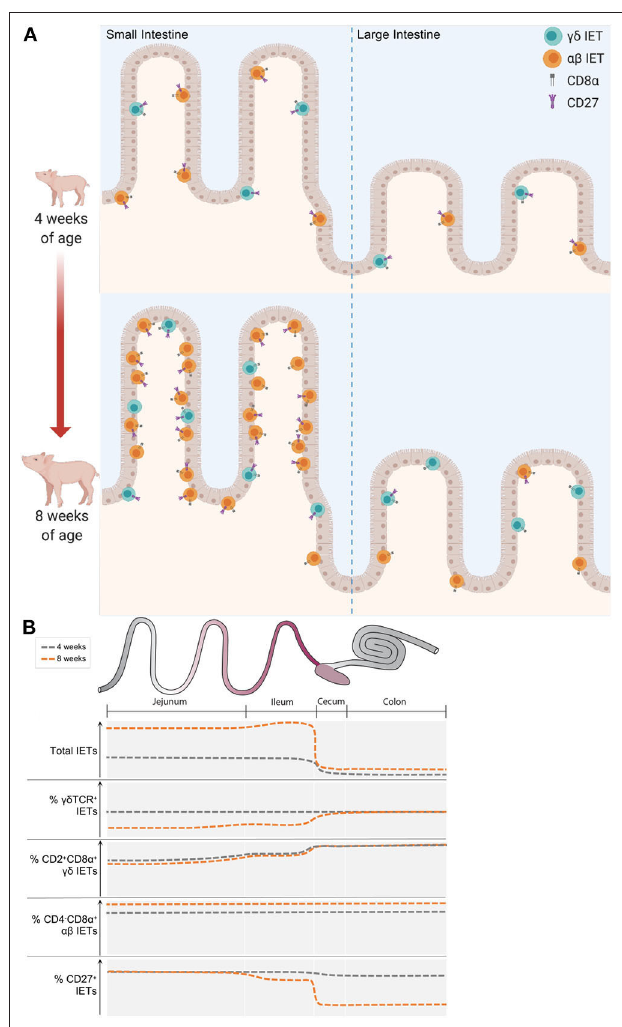
FIGURE 6 | IET community landscape was altered by intestinal location and pig age. (A) Representation of IET community landscapes in small and large intestine of 4- vs. 8-week-old pigs. γδ IETs are shown in teal, while αβ IETs are shown in orange. Expression of CD27 and CD8 α receptors are also indicated. Whether CD8 α is expressed in conjunction with another CD8 α molecule or a CD8 β molecule is unknown. (B) Summary of key changes in IET populations observed across intestinal locations in 4- and 8-week-old pigs. Y-axes show qualitative increases in measurements specified for each plot. Representative approximations in 4-week-old pigs are illustrated with dark gray dotted lines, while orange dotted lines represent approximations in 8-week-old pigs.